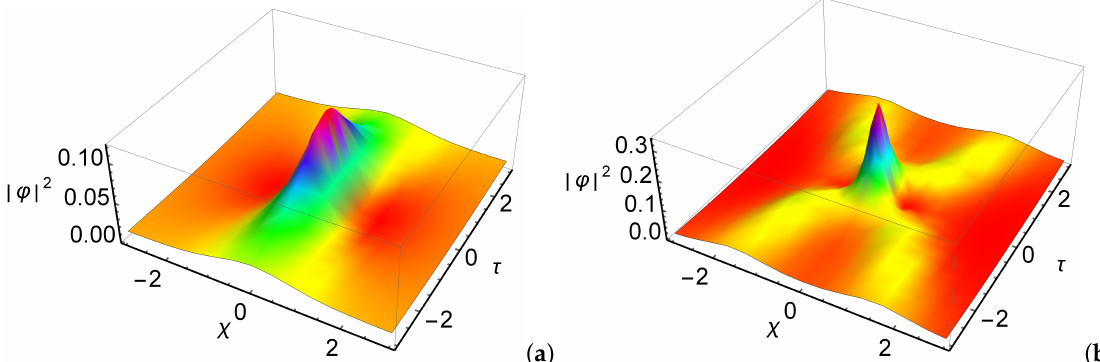
Figure 4. The 3 D plot of the amplitude of the first-order ( a ) and second-order ( b ) IARWs for ( H + , H − ) electronegative plasma (where ζ = 0 and η = 0). Here r = 1.2, q = 2, β 1 = 0.6, β 2 = 0.3, σ = 0.6, and ω ci = 0.3.